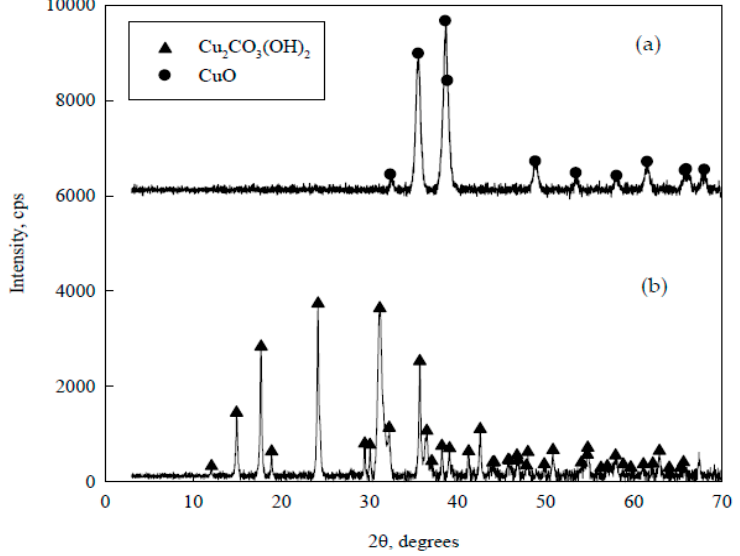
Figure 4. XRD analysis of solid samples: ( a ) samples obtained at a pH of 10.5; ( b ) samples obtained at a pH of 13.0.